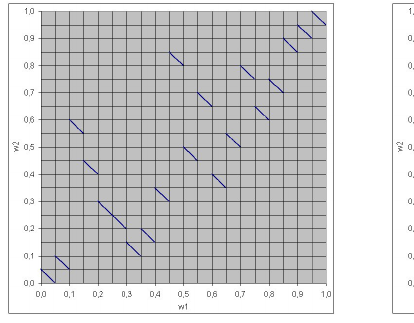
Figure 14: LF copula driver, ρ = −1